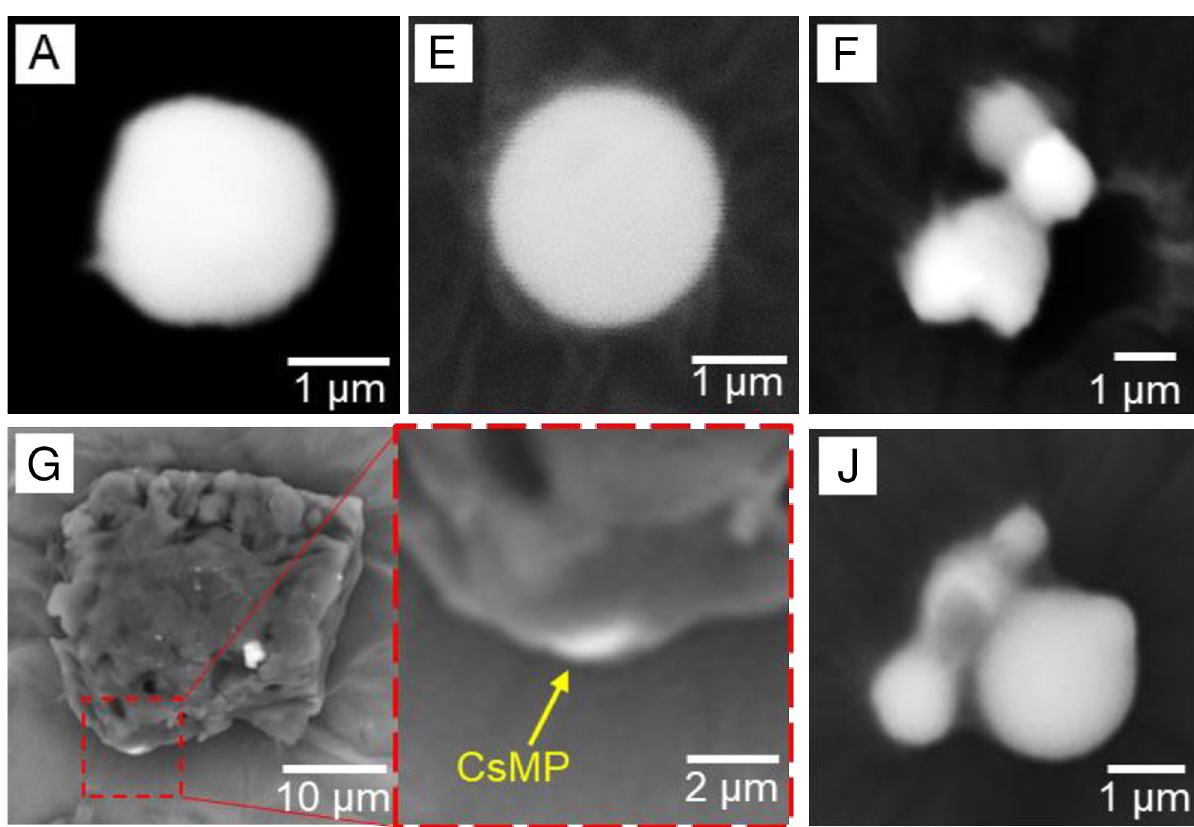
Fig 5. Scanning electron microscope (SEM) images of radiocesium-bearing microparticles (CsMPs). CsMPs were isolated from caddisfly larvae (A), periphyton (E, F), coarse particulate organic matter (CPOM) (G) and suspended solids (SS) (J). CsMPs were placed on Kapton tapes for SEM-EDS analyses. For the CsMP from G, Cs was detected only in the white area of the large particle.